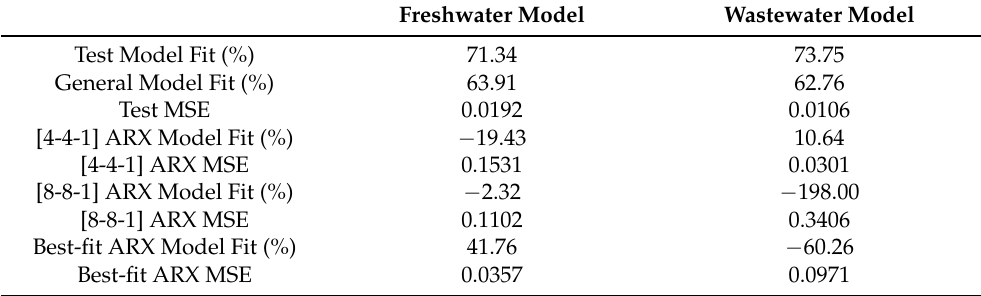
Table 5. Performance metrics for each